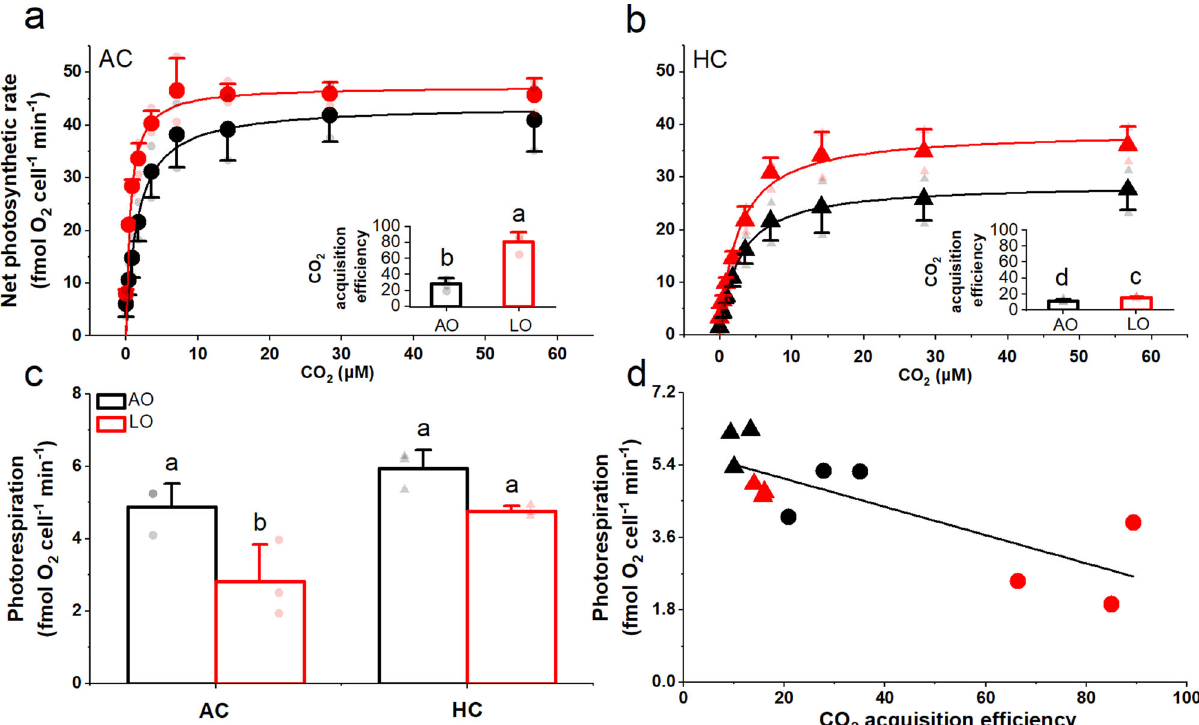
Fig. 6 Carbon dioxide acquisition ef fi ciencies and photorespiration rates of the diatom Thalassiosira weiss fl ogii grown under varying levels of p CO 2 and p O 2 . Net photosynthesis vs CO 2 concentration curves was compared under standard conditions (pH T = 8.00, light of 400 μ mol photons m − 2 s − 1 , and DO of 50 – 200 μ M) for cells grown under ( a ) ambient CO 2 (AC, circles, ~15 μ M) and ( b ) high CO 2 (HC, triangles, ~35 μ M) at ambient (AO, black symbols, ~255 μ M) and low O 2 levels (LO, red symbols, ~57 μ M). Insets present CO 2 acquisition ef fi ciencies ( V max / K 0.5 for CO 2 ). ( c ) Photorespiration of cells under the growth p CO 2 and p O 2 levels. ( d ) The correlation between photorespiration and CO 2 acquisition ef fi ciency ( P = 0.0023, r = − 0.7886, Pearson correlation analysis, two-tailed). The values represent means ( a – c ) or all replicate data ( d ), and error bars indicate the standard deviations of independent biological replicates ( n = 3). Light-colored symbols are individual data corresponding to the treatments. Different letters above the bars represent signi fi cant differences ( P < 0.05, LSD test) among the treatments. The detailed information for the experimental features and timing points for the above